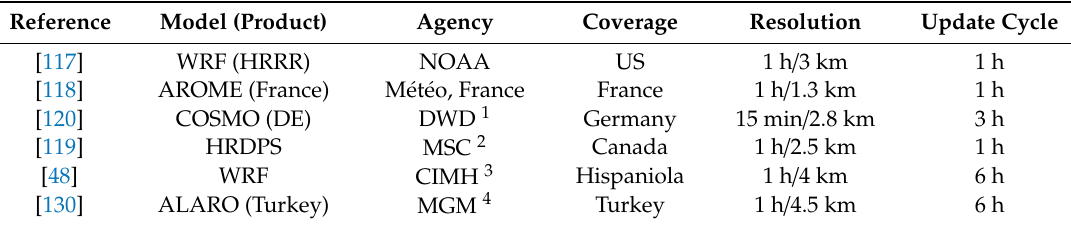
Table 3. Selected CP-NWP operational quantitative precipitation forecast (QPF) products sorted by spatial